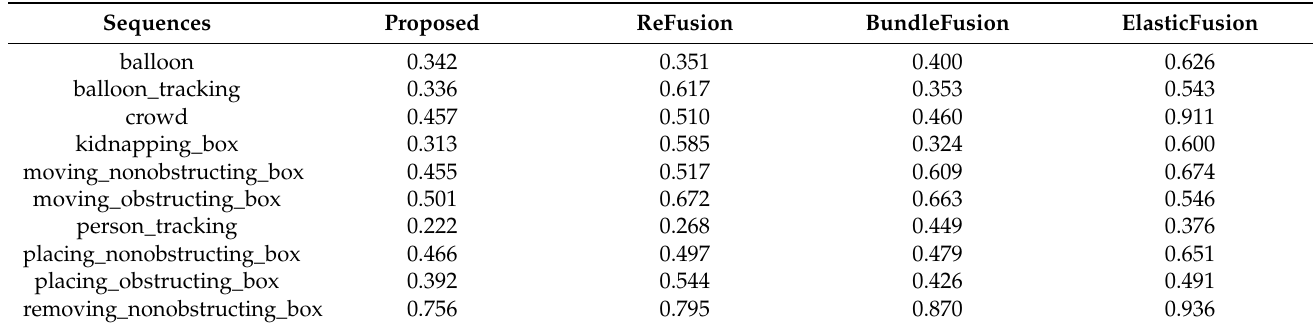
Table 1. Surface reconstruction error (m) evaluated on the BONN dataset by [18].